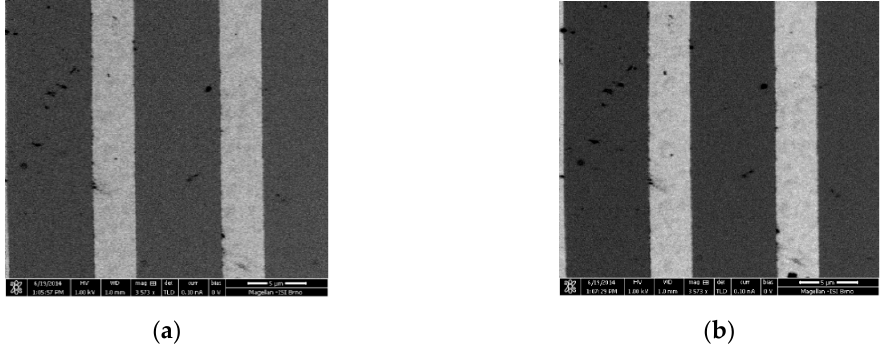
Figure 9. Ag (3 µ m) / Cr (6 µ m) stripes on a silicon substrate, without potential on the sample; standard TLD SE mode ( a ), BSE filtered image, without SEs1 (U ST = − 150 V) ( b Figure 9. Ag (3 µm)/Cr (6 µm) stripes on a silicon substrate, without potential on the sample; standard